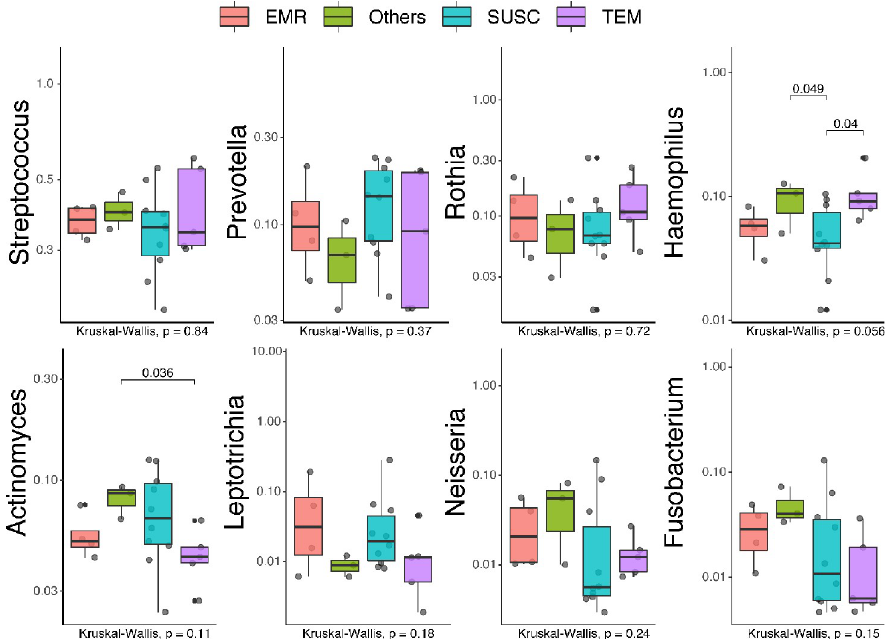
Fig 5. Distribution of bacterial genera/species stratified by resistance groups. Box plots illustrate the abundance of selected genera/species across resistance groups. Overall, 22 samples were analyzed being 4 (18.2%) positive for the erm gene (EMR group), 6 (27.3%) for the bla TEM gene (TEM group), 2 (9.1%) for mec A and pbp 2 genes (Others group), and 10 (45.5%) negative for all searched genes (SUSC group). The boxes represent the interquartile range (IQR) between the first and third quartiles (25th and 75th percentiles, respectively). The vertical line inside each box defines the median. Whiskers represent the upper and lower adjacent values. Gray circles are outliers. The number of reads (Y-axis) was used as a proxy for abundance. Scientific exponential notation (E-notation) was used for Rothia , Leptotrichia , and Neisseria boxplots. “ m e+ n ” indicates the value of “ m × 10 n ”. P -values of pairwise comparisons are displayed above each block analyzed (T-test, Wilcox, Tukey and ANOVA tests). Final adjusted P -values are shown on the lower-left corner of each plot